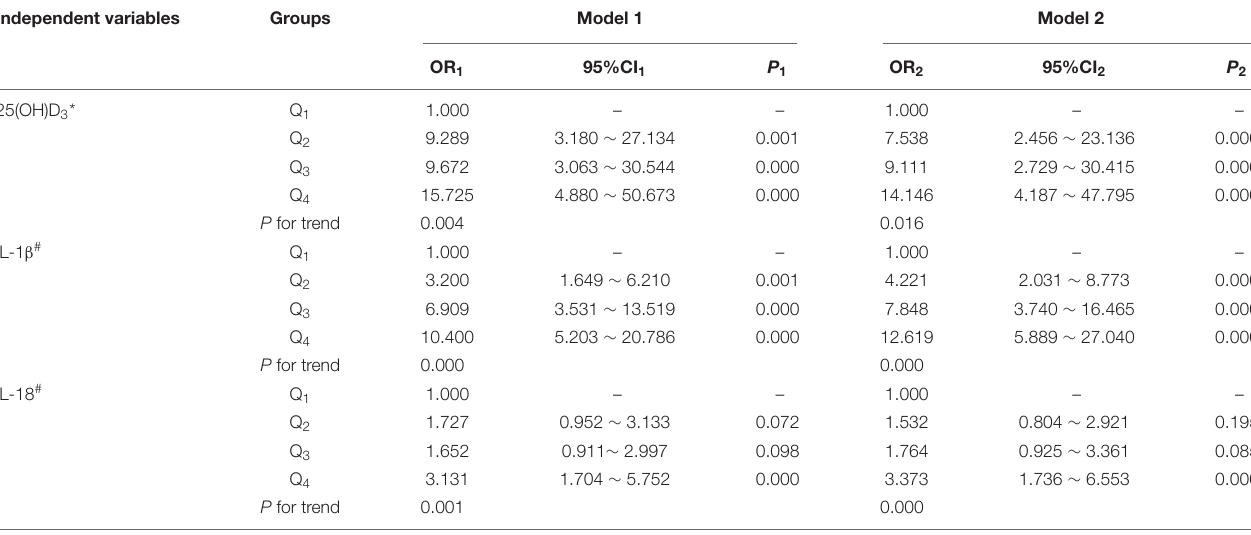
Model 1: Crude model. Model 2: Adjusted for age, gender, education, economic status, BMI, smoking status (yes/no), drinking status (yes/no), exercising status (yes/no), hypertension (yes/no), diabetes (yes/no), and hyperlipoidemia (yes/no). *The groups of 25(OH)D 3 status Q 1 for sufficient; Q 2 for insufficient; Q 3 for deficiency; Q 4 for severe deficiency. # The groups of IL-1 β were divided by quartiles: Q 1 for < 25% ( ∼ 5.96 pg/mL); Q 2 for 25–50% (5.98–6.65 pg/mL); Q 3 for 50–75% (6.66–7.41 pg/mL); Q 4 for > 75%